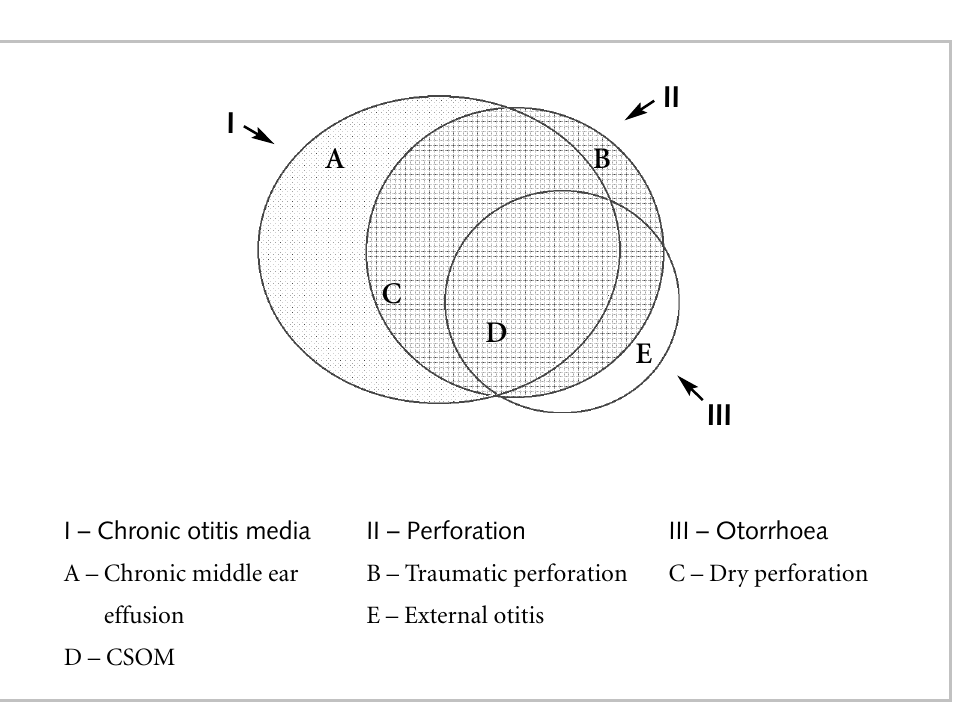
Figure 1. Relationship of different definitions to